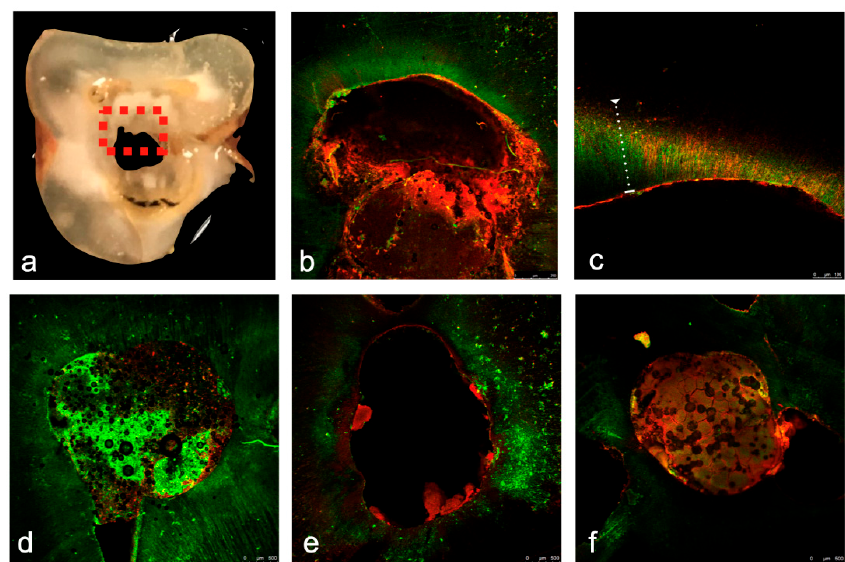
Figure 2. ( a – f ). Confocal laser scanning microscopy (CLSM) images. The specimens were cut through the perforation site containing the repair materials perpendicularly to the long axis of the root in order to be evaluated by the CLSM. The perforation site can be clearly seen, and the dotted square represents a single evaluated area ( a ). Prior to scanning, LIVE/DEAD Kit stained the infected dentin. Vital ( Green ) and dead ( Red ) bacteria inside the dentinal tubules in the evaluated areas are clearly visible ( b – f ). Positive control ( b , c ), MTA-Angelus ( d ), Endocem ( e ) and Biodentine ( f ) groups showing fluorescence staining. Significantly more dead bacteria ( Red Staining ) than live bacteria ( Green Bacteria ) were detected on the dentinal surface at the circumference of the perforation defect ( d – f ), and significantly more live ( Green Staining ) bacteria than dead bacteria down in the dentin inside the dentinal tubules ( b – f ) were detected in all groups. There were significantly more dead bacteria than live bacteria on the dentinal surface at the circumference of the perforation defect ( p = 0.0041) and significantly more live bacteria than dead bacteria down in the dentin inside the dentinal tubules, for all directions ( p = 0.0023) in all groups. (Figure 3). The ratio of live to dead bacteria was significantly higher in the MTA-Angelus group when compared with the other repair material groups ( p = 0.001).